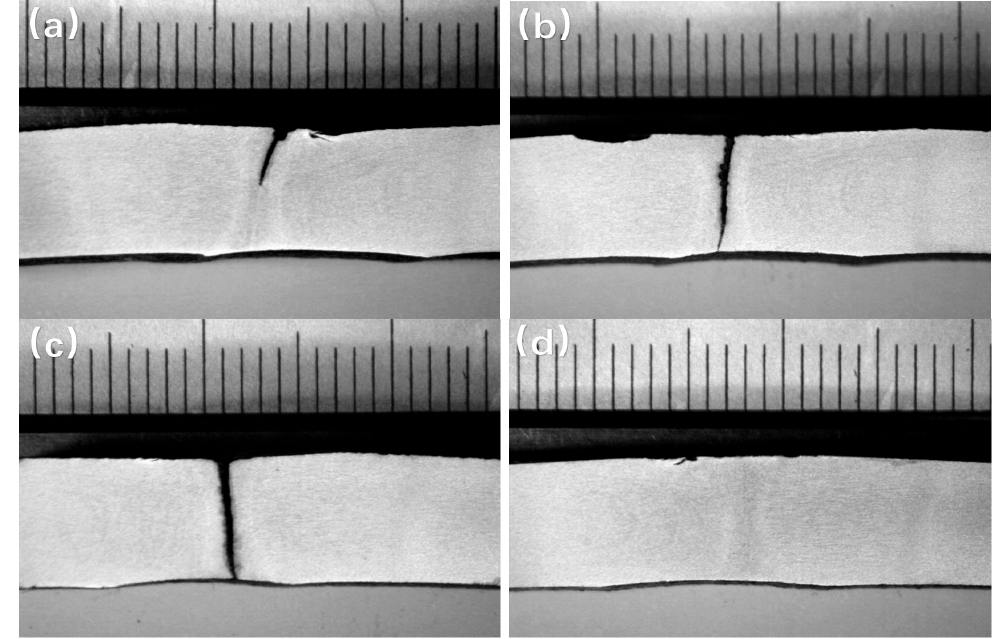
Figure 5. Macromorphology of weld seam of 2# cracking pipe: ( a ) C2; ( b ) C3; ( c ) C4; ( d ) C5.